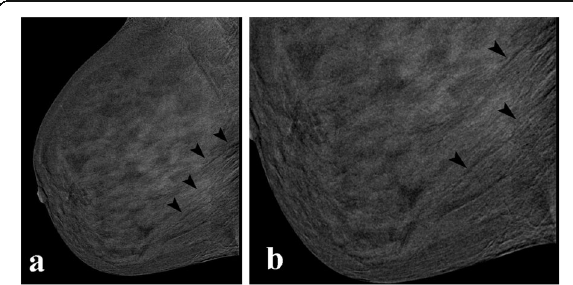
Fig. 11 Ripple artefact. CEDM performed for preoperative staging. The arrowheads are indicating the ripple artefact, which are seen as thin alternate dark and light lines in the recombined image ( a ). The artefact is more visible in the magnified view ( b ,